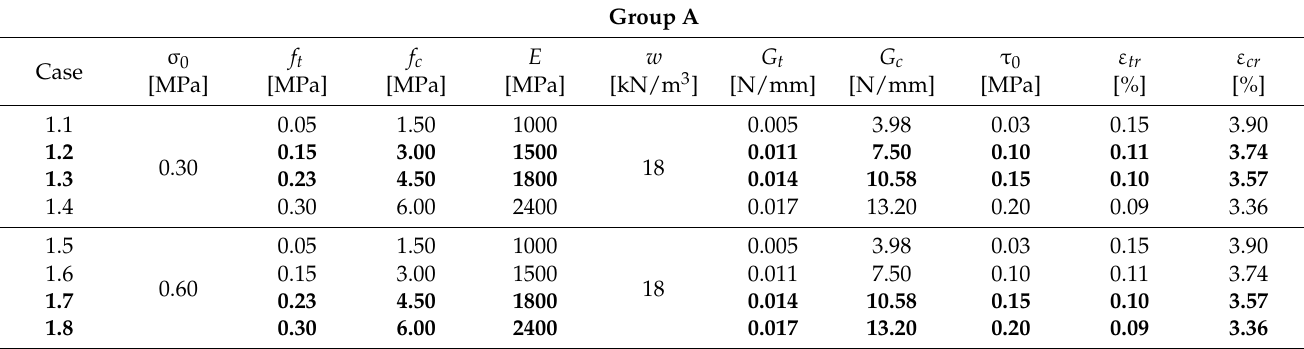
Table 3. Mechanical properties used in the sensitivity analyses for Group A. Group A